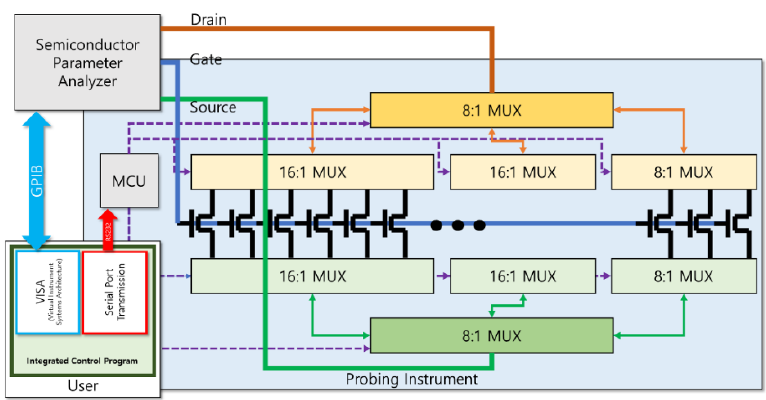
Figure 4. The key map of controlling flow: the integrated program in a PC controls the semiconductor parameter analyzer and the probing instrument simultaneously. After selecting a switch for measurement by commanding the MCU of the probing instrument, the integrated program orders the semiconductor parameter analyzer to sweep gate voltages and receives the measured drain current data.